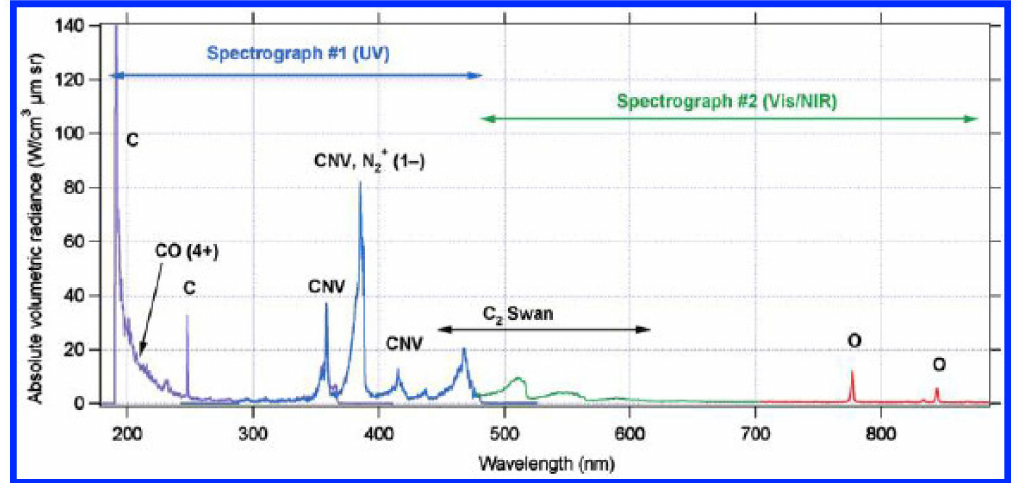
Figure 17. Emission spectrum for a Mars atmosphere (96% CO 2 , 4% N 2 ) at 13.3 Pa and a shock velocity of 8.6 km/s (from [23]).